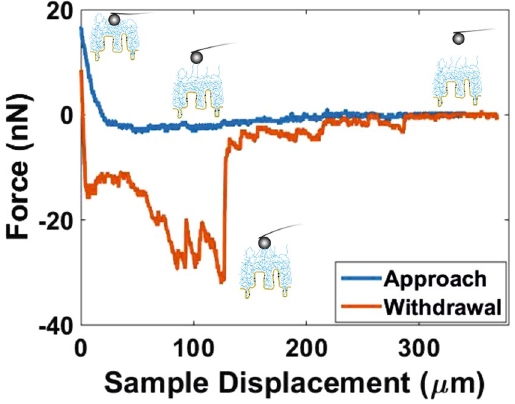
Figure 3. Representative force measurement on ileum mucosa in PBS pH